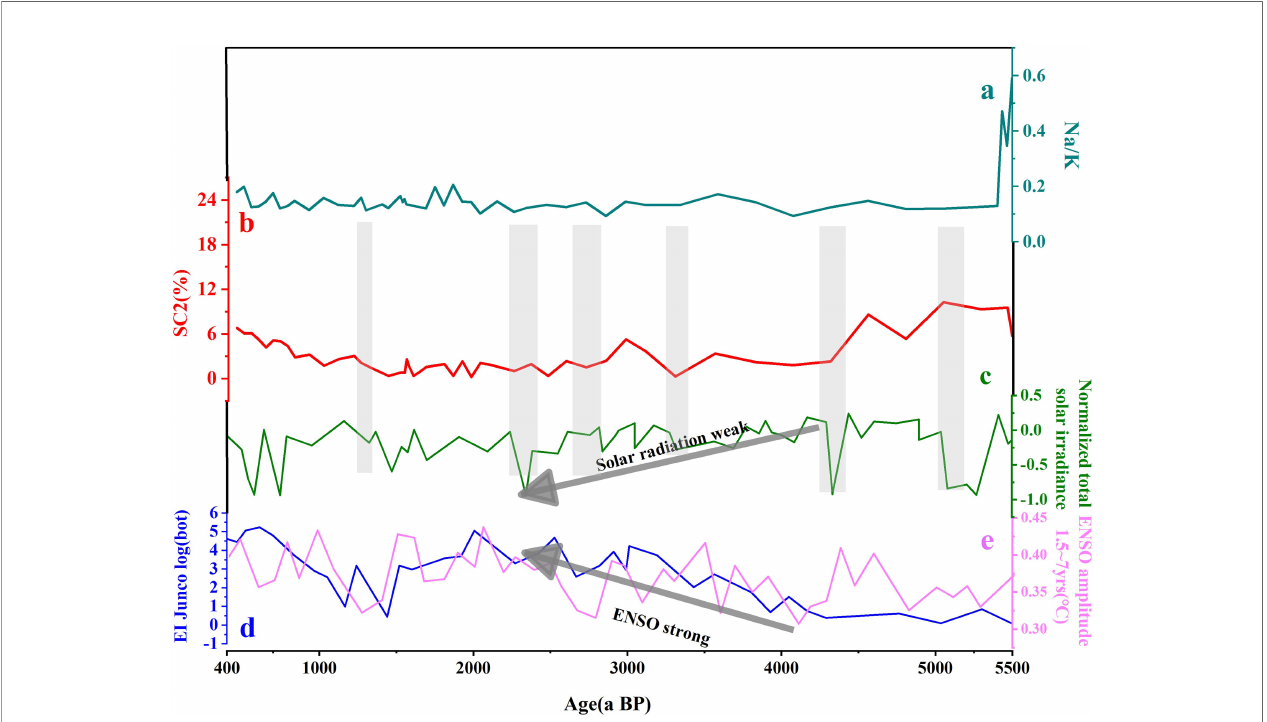
FIGURE 7 | Comparison of multi-decadal to centennial time scale climate changes recorded in GGL section (A, B) with potential forcing factors (C – E) . (A) Na/K ratio in the GGL section; (B) grain size sensitive component 2 content in the GGL section; (C) normalized total solar irradiance reconstructed from a cosmic ray intensity record (Steinhilber et al., 2012); (D) ENSO-like record from Lake El Junco indicated by the Botryococcene concentration (Conroy et al., 2008); (E) ENSO amplitude simulation results in the 100-year window from CCSM3 model (Liu et al.,